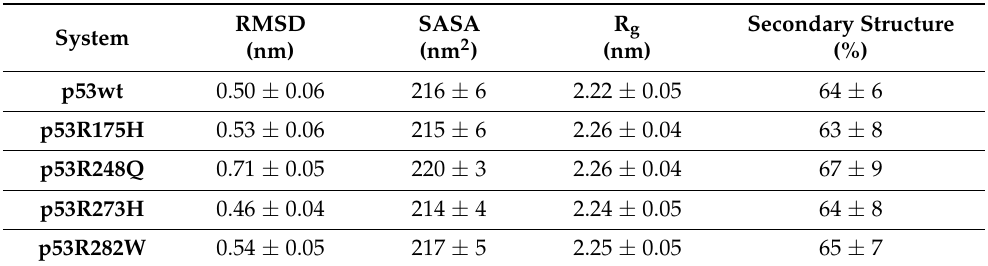
Table 1. General properties of p53wt and the four p53 mutants. RMSD, SASA, and Rg were evaluated from the 50–150 ns interval of the runs, while the percentage of the secondary structure was evaluated from the average structure from the last 10 ns (141–150 ns) of the runs.